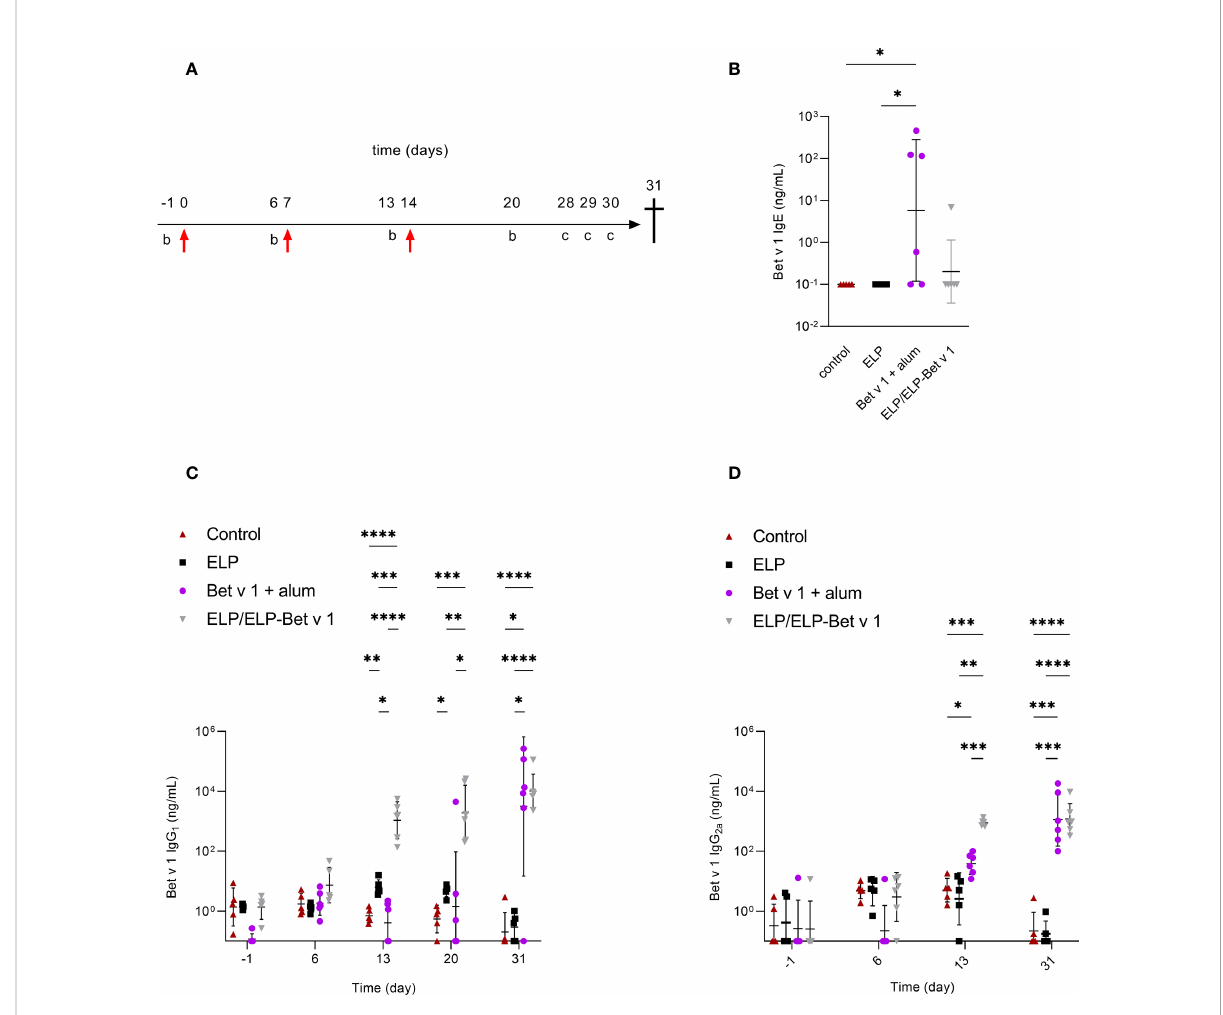
FIGURE 7 In vivo immunogenicity in naïve mice. (A) Immunization protocol. Mice were immunized with 36 µg Bet v 1 on day 0 by subcutaneous injection followed by booster immunizations on days 7 and 14 (red arrows). Blood samples were taken for serum immunoglobulin analyses on days -1, 6, 13 and 20. The mice received intranasal BPE challenges (C) to further boost immunoglobulin production on days 28, 29 and 30. At day 31 the mice were sacri fi ced. (B) Serum Bet v 1-speci fi c IgE levels at day 31. (C) Serum Bet v 1-speci fi c IgG 1 levels on days -1, 6, 13, 20 and 31. (D) Serum Bet v 1-speci fi c IgG 2a levels on days - 1, 6, 13 and 32. Day 20 data are not available because of incorrect storage of the corresponding serum samples. *p<0.05, **p<0.01, ***p<0.001 and